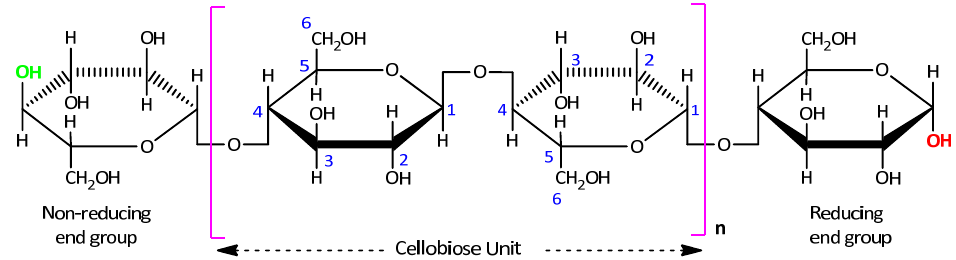
Figure 1. Schematic diagram of the partial molecular structure of cellulose chain with numbering for carbon atoms and n = number of cellobiose repeating unit [12].